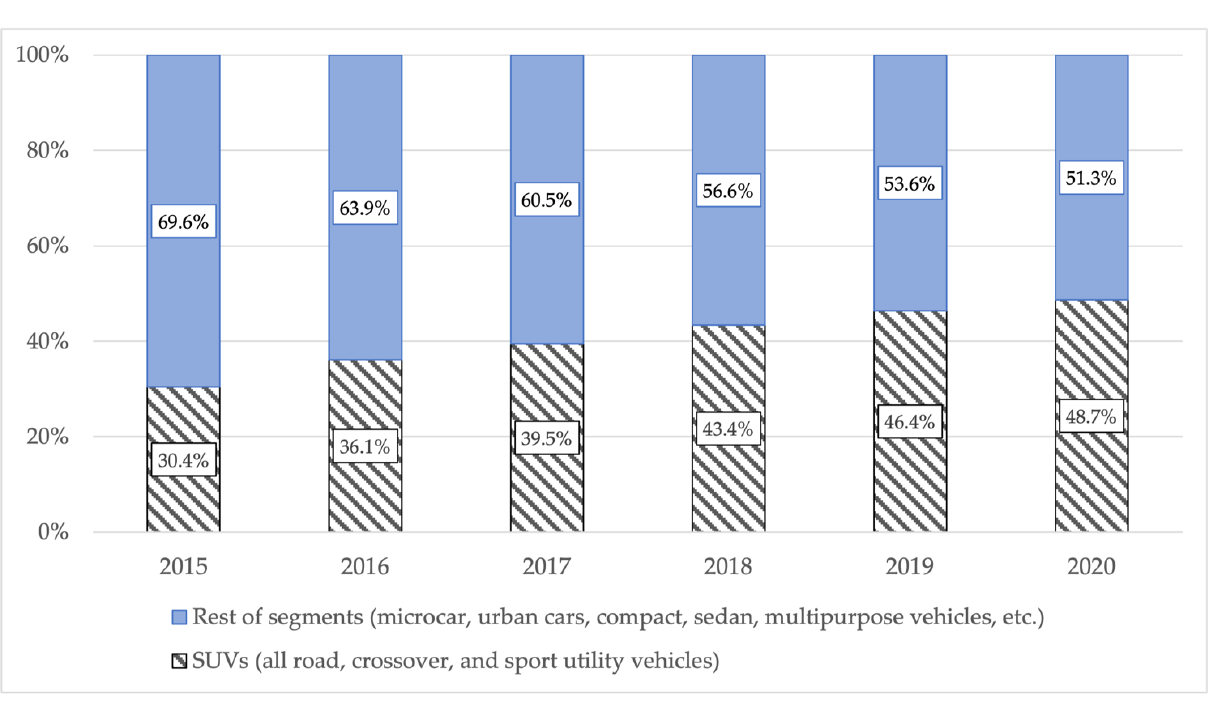
Figure 1. Market share by segments in the Canary Islands.